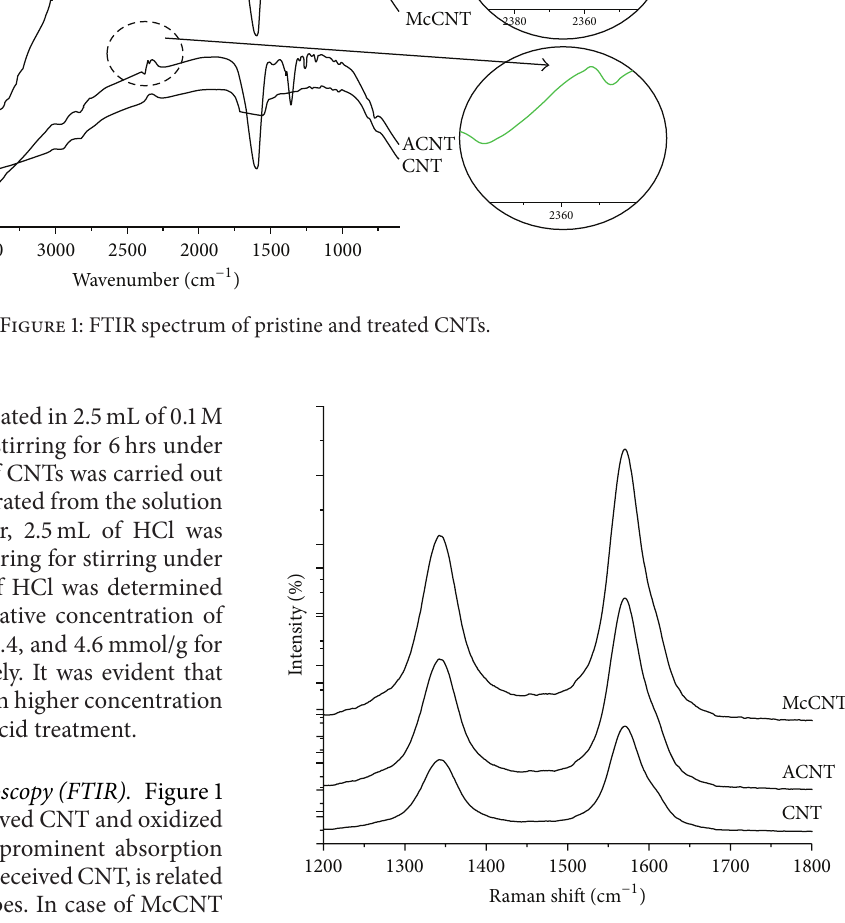
Figure 2: Raman spectrum of pristine and oxidized